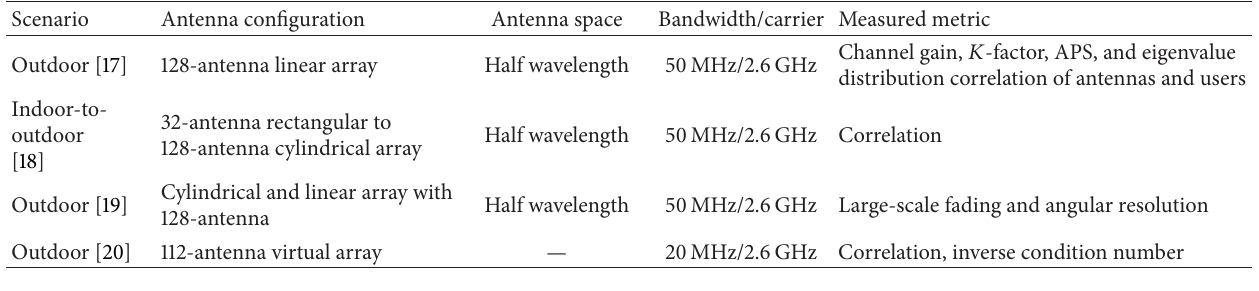
Table 2: Channel measurement.